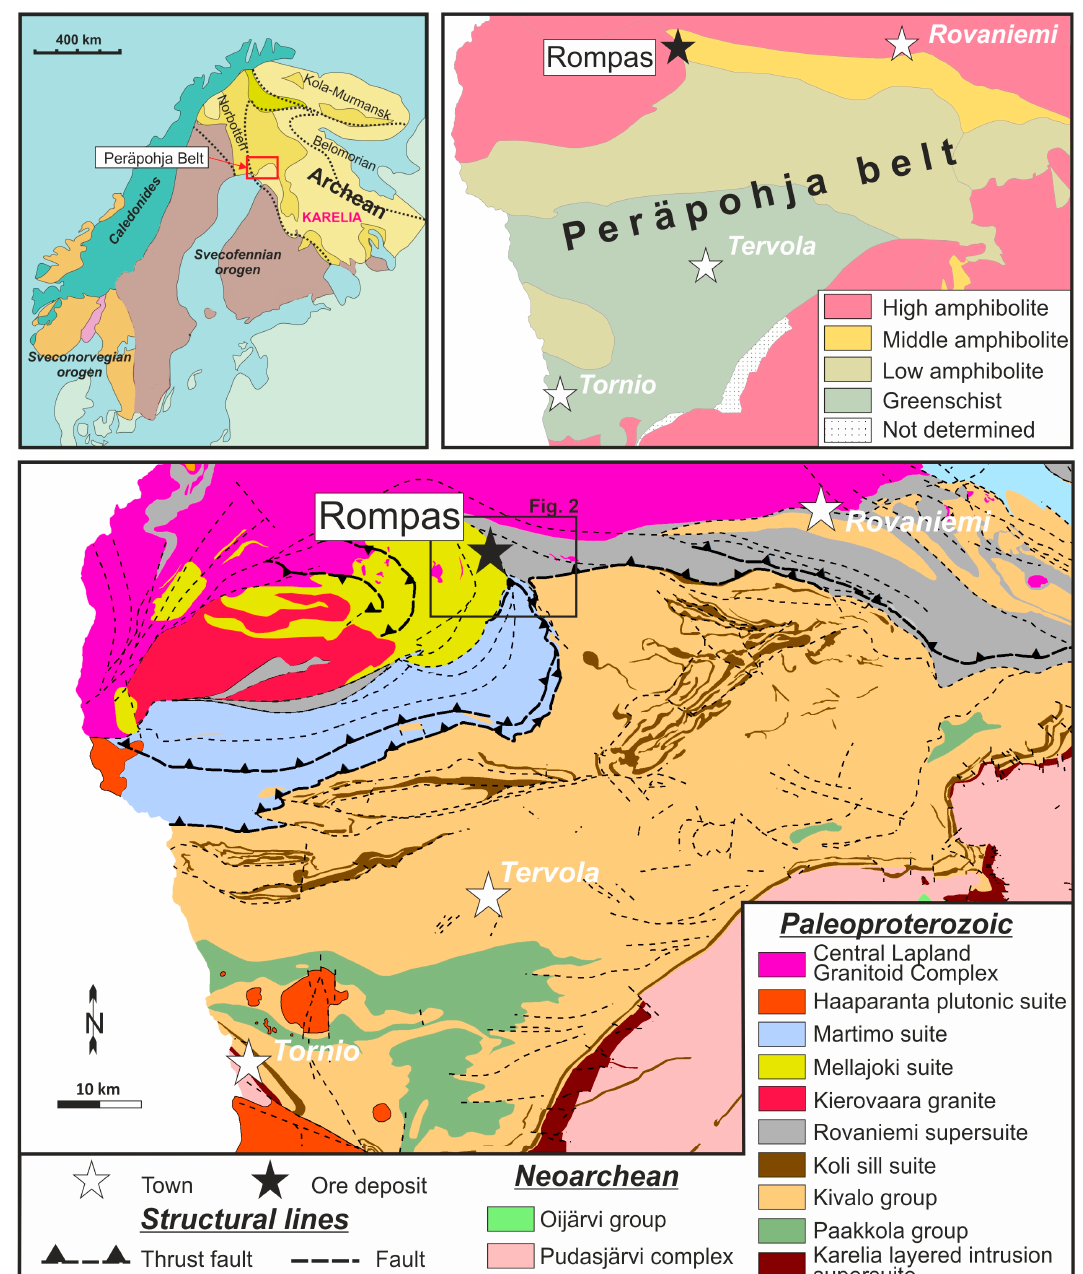
Figure 1. Regional geology and metamorphic zoning in the Peräpohja belt and location of the Rompas Au–U deposit. Simplified base map and metamorphic map from the DigiKP Finland geographic information system GIS database of Geological Survey of Finland as of July 2017.